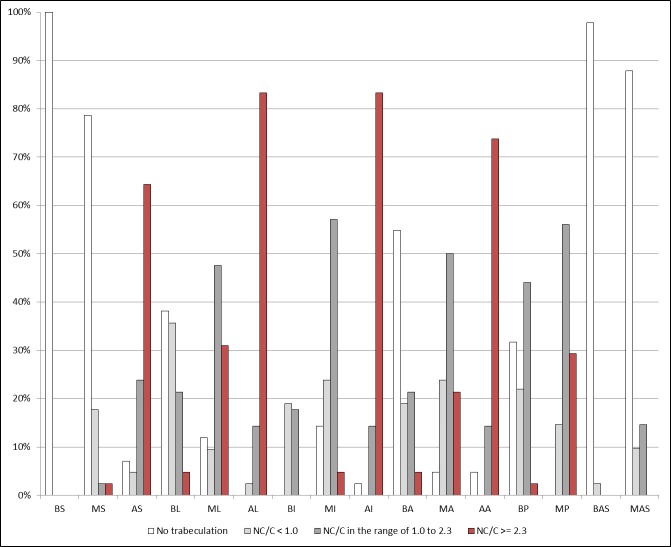
The graphical distribution of the left ventricular trabeculation in the left ventricular noncompaction group.The vertical axis presents the percentage of the left ventricular segments with the extent of trabeculation described by the noncompacted to compacted layer thickness ratio (NC/C) localized on the horizontal axis. The left ventricular segments description: basal, middle, and apical septal segments (BS, MS, AS), lateral segments (BL, ML, AL), inferior segments (BI, MI, AI), anterior segments (BA, MA, AA), basal and middle posterior segments (BP, MP) and anteroseptal segments (BAS, MAS).